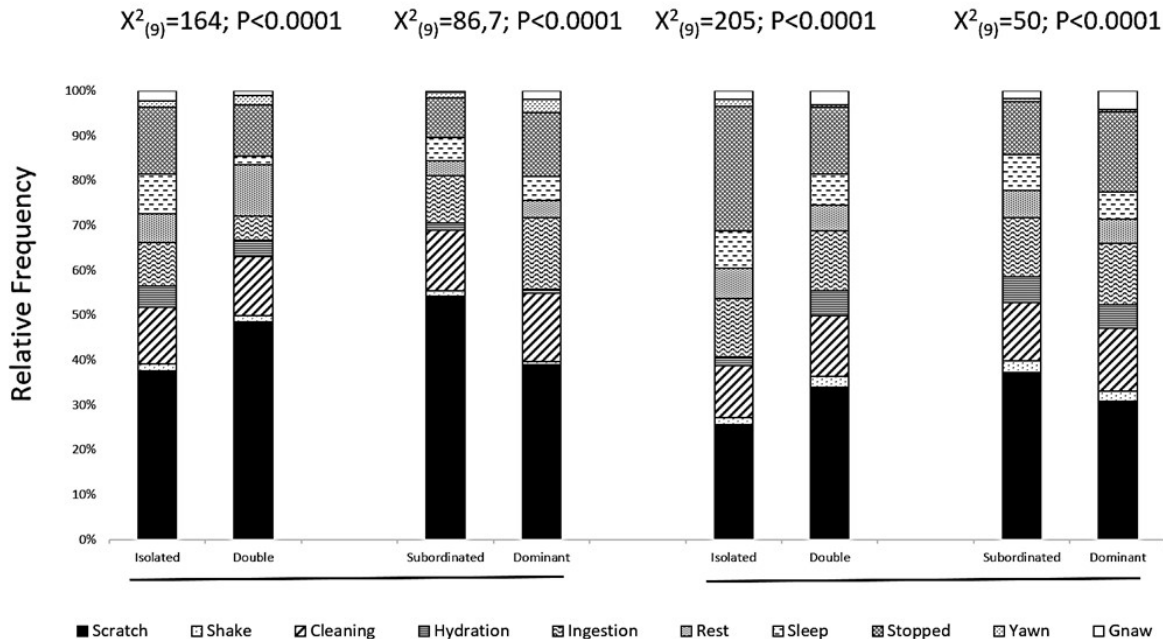
Figure 1. Relative frequency of motor standards for maintenance category. Absolute frequencies were compared between isolated and double animals and between subordinate and dominant animals using the chi-square test, with significantly higher values (P <0.05) accompanied by an asterisk